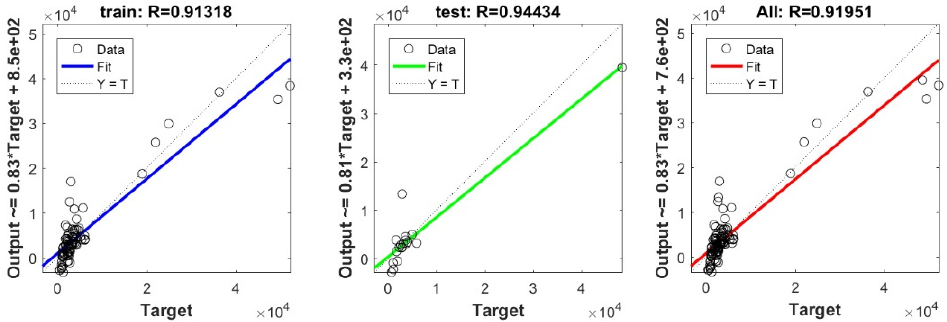
Figure A10. Scatter plots between target and output values by the STEP model.